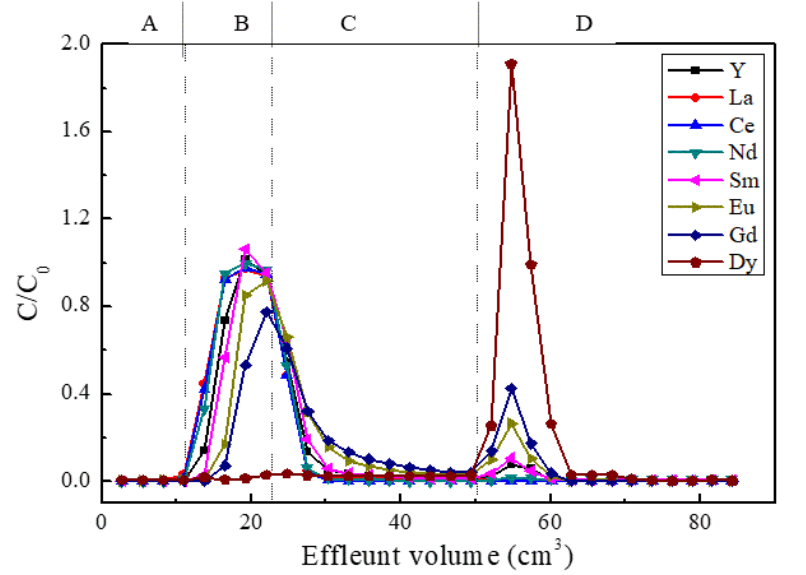
Figure 7. Column dynamic adsorption–elution experiment results for a Ln(III) mixed sample solution using iso Bu-BTP/SiO 2 -P adsorbent (column: ø10 mm × h 300 mm; flow rate: 0.3 mL/min; temperature: 298 K): ( A ) washing solution (0.01 M HNO 3 –0.49 M NaNO 3 ); ( B ) feed sample solution; ( C ) rinsing solution (0.01 M HNO 3 –0.49 M NaNO 3 ); ( D ) 0.01 M